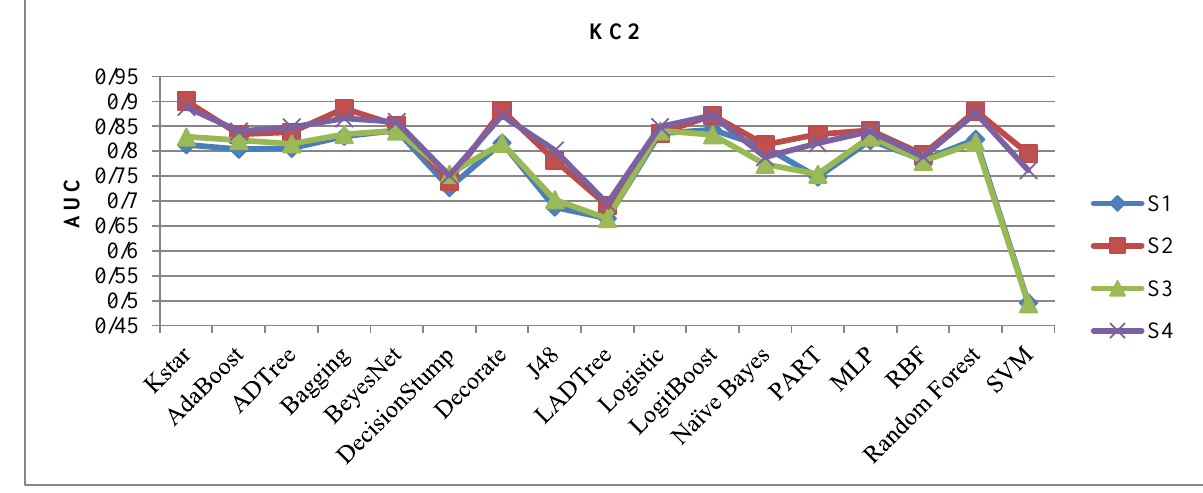
Figure 6. Performance evaluation of 17 data classifiers for KC2 dataset.